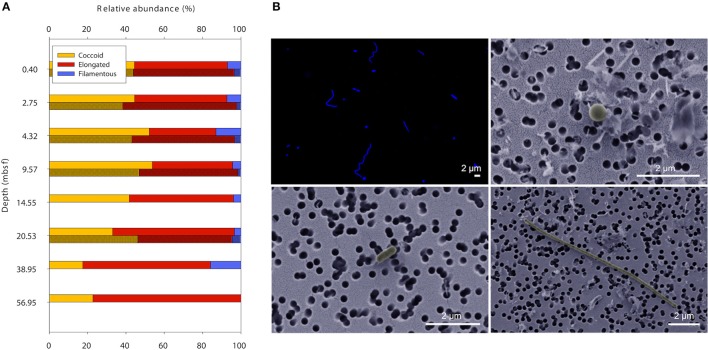
Cell shapes throughout 60 meters of sediment at Landsort Deep. (A) The majority of microbial cells in the sediment have coccoid or slightly elongated morphology, whereas filamentous cells are rather scarce. Data obtained with FM (lighter shade) and SEM (darker shade). (B) Typical images of DAPI-stained cells seen with FM (upper left), and coccoid (upper right), elongated (lower left), and filamentous cells (lower right) seen with SEM.